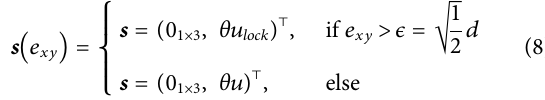
Frontiers in Robotics and AI |